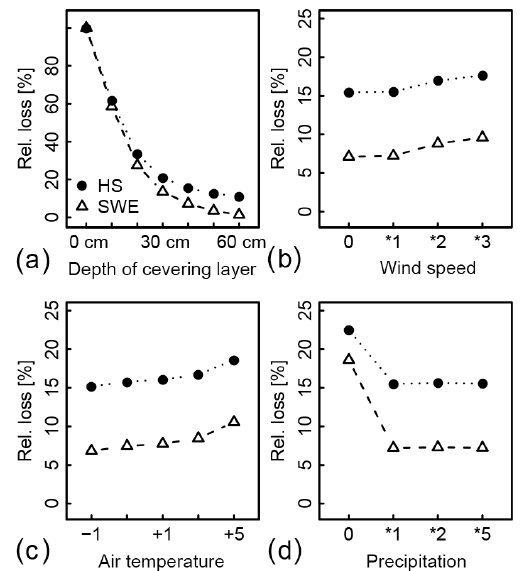
Figure 10. Relative loss of snow height (HS) and snow water equiv- alent (SWE) calculated by SNOWPACK simulations with different thicknesses of the sawdust layer (a) , different wind speeds (b) , air temperatures (c) and precipitation (d) .